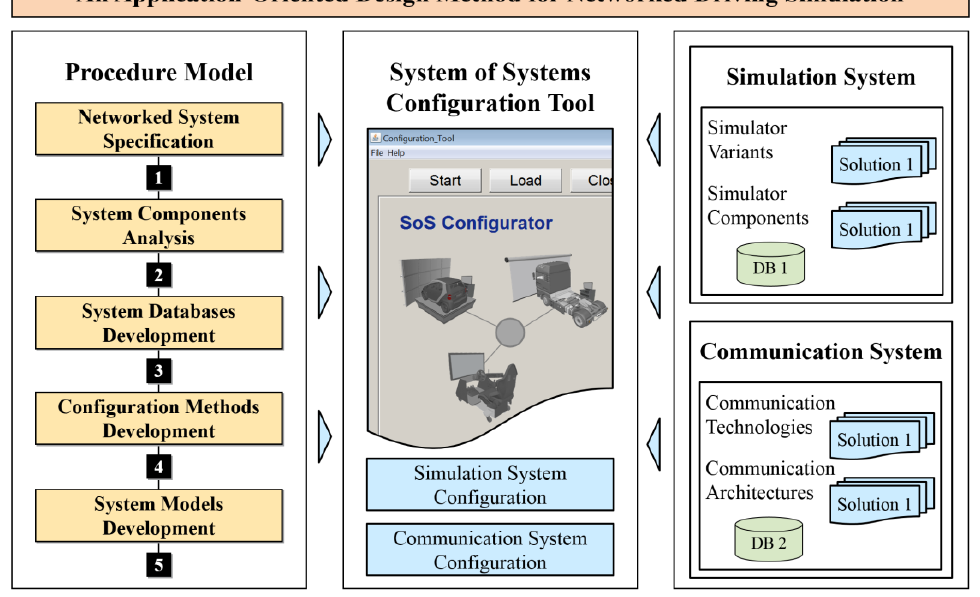
Figure 3. The fundamental components of the developed design method for networked driving